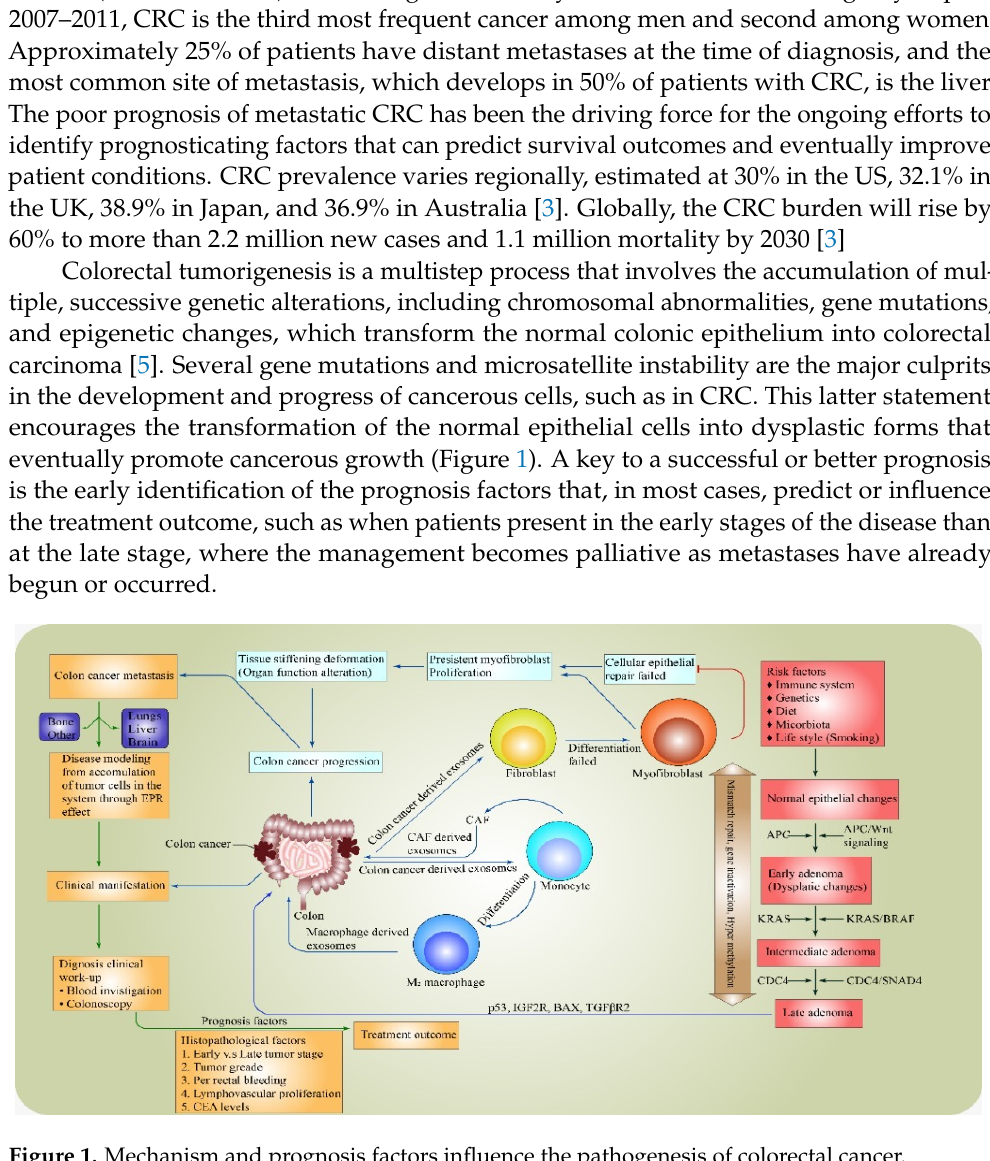
Figure 1. Mechanism and prognosis factors influence the pathogenesis of colorectal cancer.